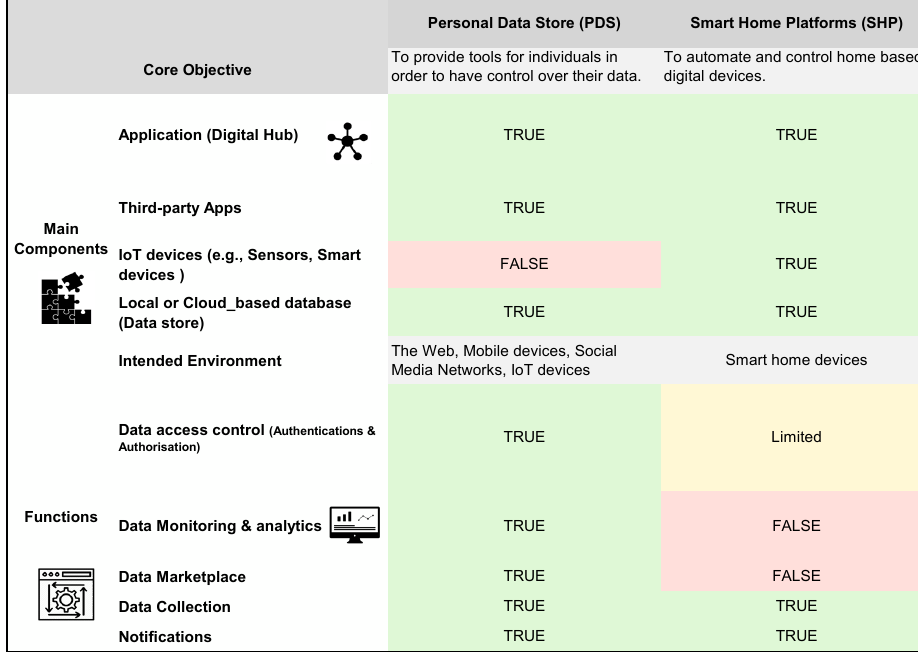
Figure 2. Similarities and differences between PDS platforms and Smart Home